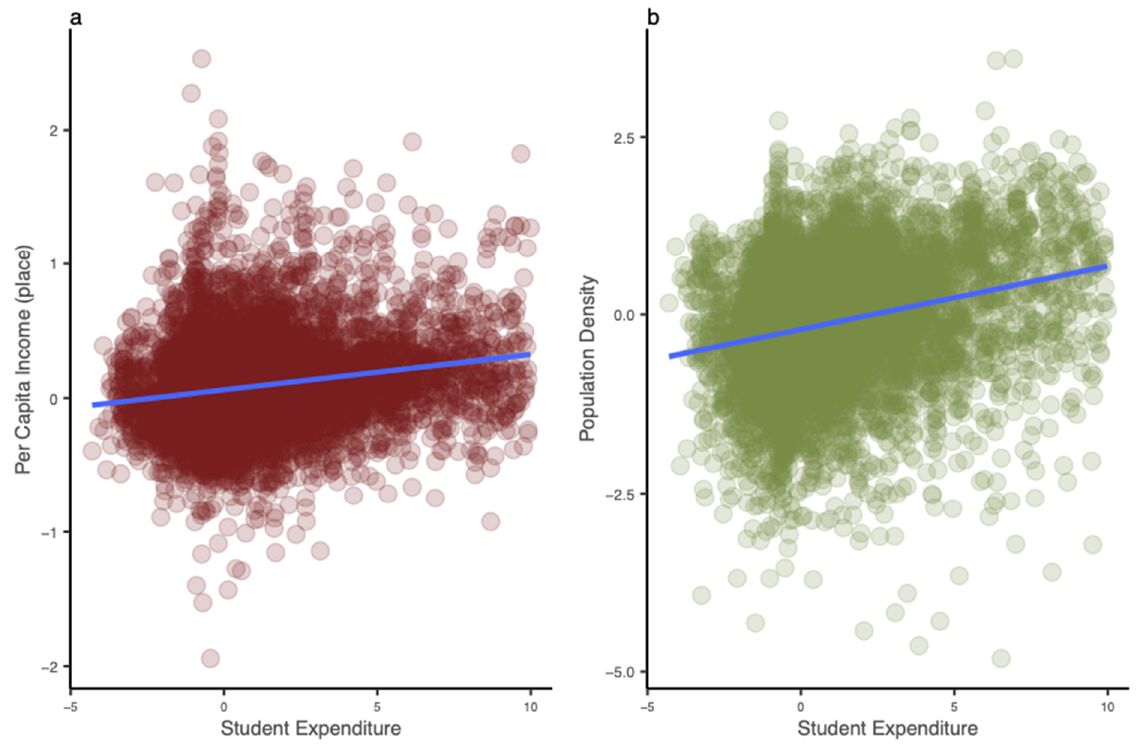
Figure 4. 2017 student expenditure statistics plotted by per capita income and population density. Both per capita income and population density have been centered and logged and are positively correlated with education